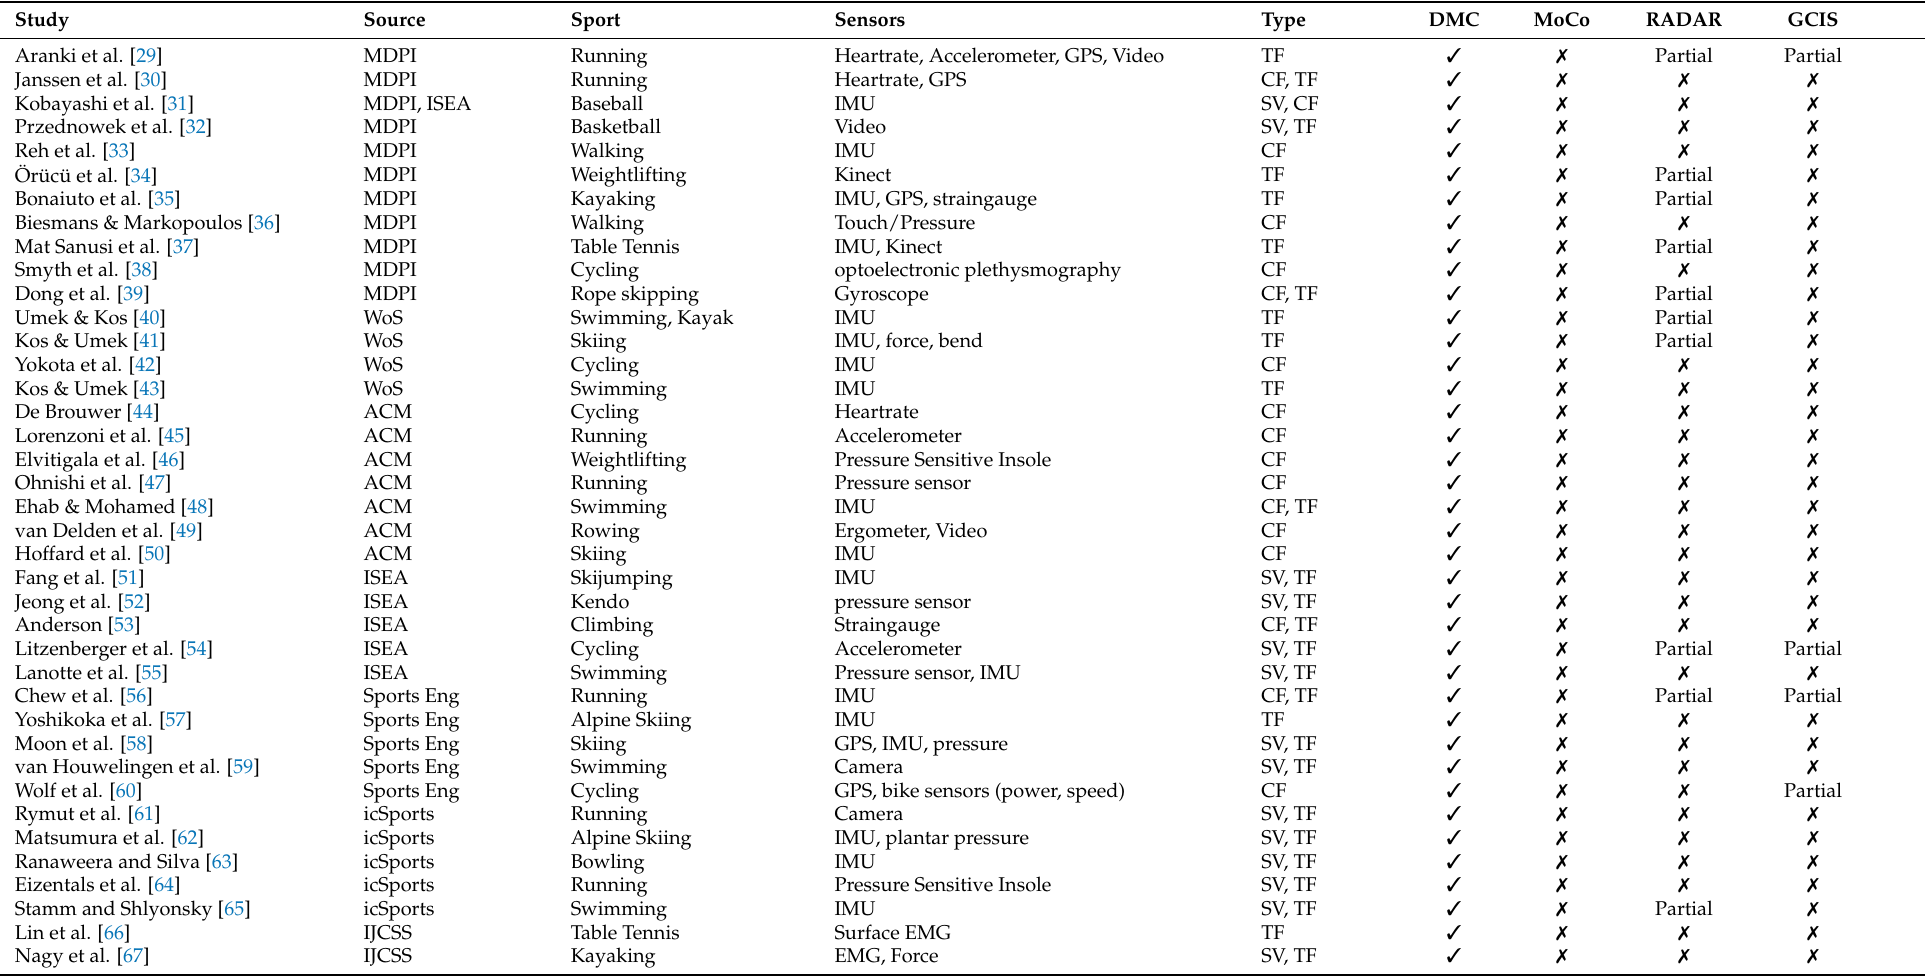
Table 4. Summary of studies. Study types: Concurrent Feedback ( CF ), Sensor Validation ( SV ) or Terminal Feedback ( TF